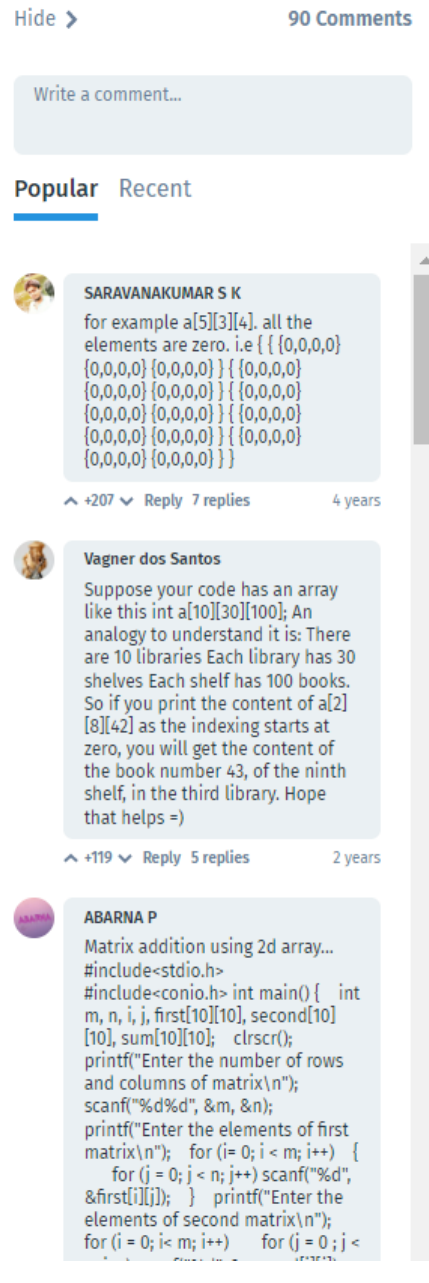
switch, and three types of loops: for, while, do...while. The section also included theory on logical operators, which are &&, which means “i”, and ||, which means “or”.